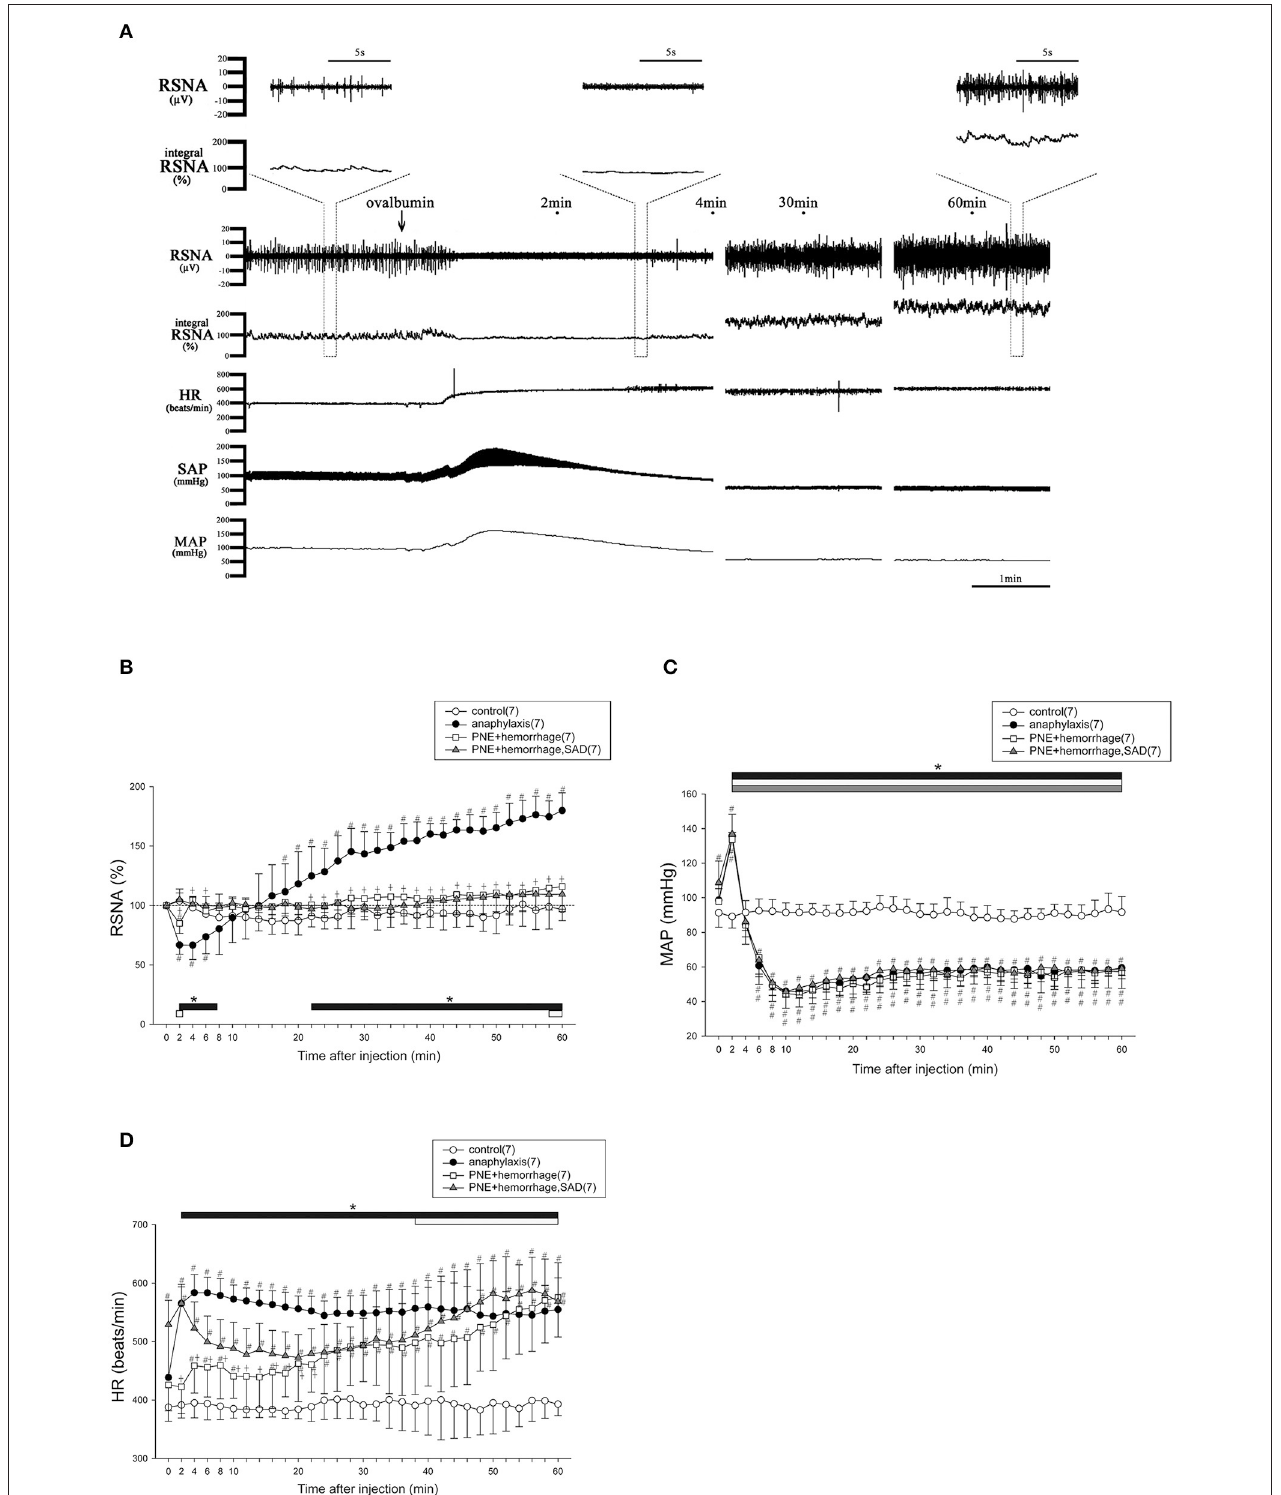
FIGURE 1 | The changes in RSNA and hemodynamic variables after antigen injection in anesthetized mice. The typical raw data of RSNA and cardiovascular responses to anaphylaxis are presented, and expanded raw data of RSNA are represented in upper area (A) . Time-course data of the changes in RSNA (B) , MAP (C) , and HR (D) after antigen injection or treatment of PNE injection and hemorrhage in mice are also shown. • , the sensitized mice (anaphylaxis); ◦ , the nonsensitized